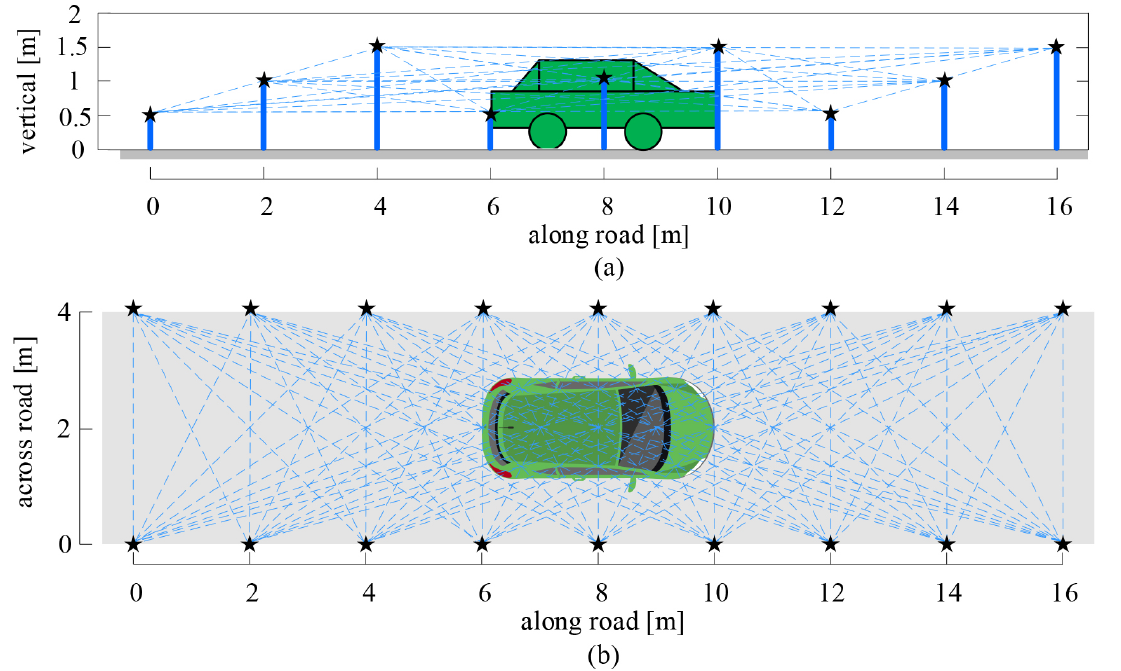
Figure 1. Diagram of the three-dimensional device-free localization (3D-DFL) model for a roadside vehicle. The gray shadow is the road, the black pentagrams are the sensor nodes, and the blue dashed lines are communication links. ( a ) Vertical view; ( b ) front